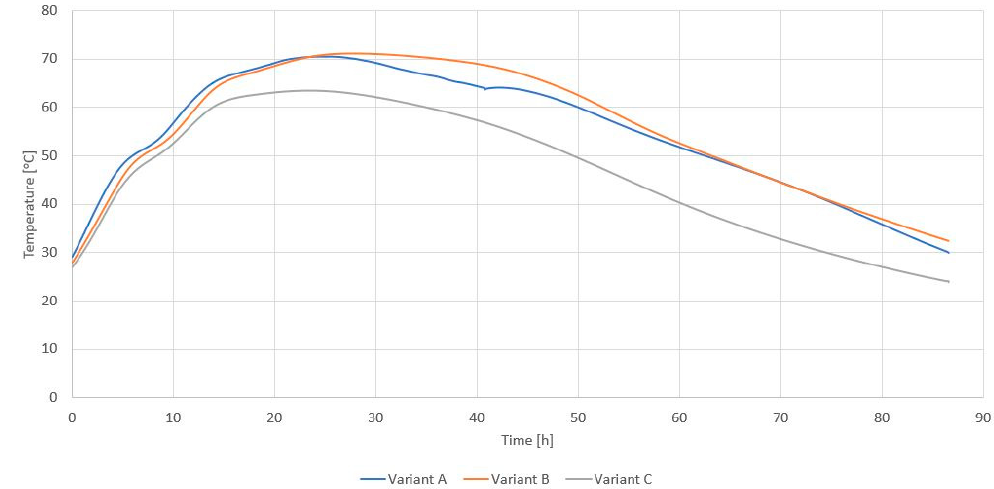
Figure 3. Averaged result of measurements of temperature changes inside EWA bioreactors during refuse-derived fuel (RDF) biodrying with characteristics A, B, and C (own research). Despite the fact that the process lasted only four days and the thermophilic phase was shorter